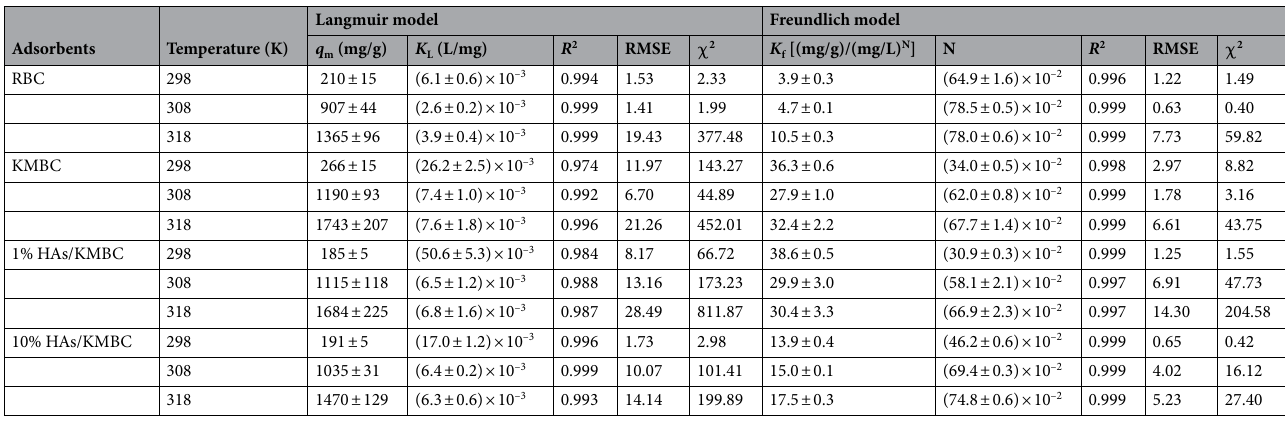
Table 2. Fitting parameters of the Langmuir and Freundlich models.